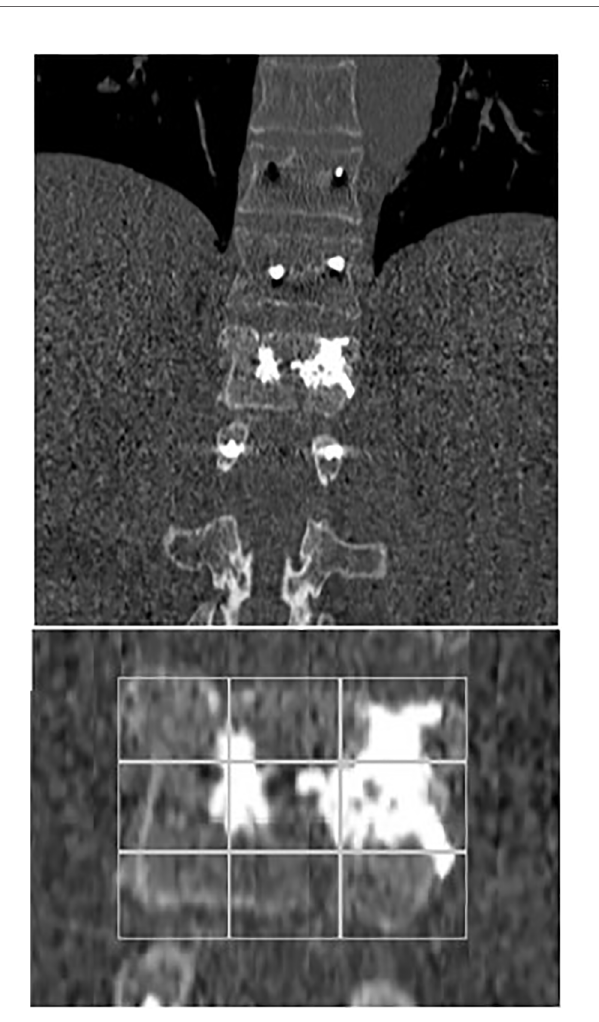
FIGURE 7 | Coronal early post-operative CT scan showing an L1 average cement fi lling based on Saliou fi lling score 11/18 (6 + 5) and a T11-T12-L2 vertebral fi xation.